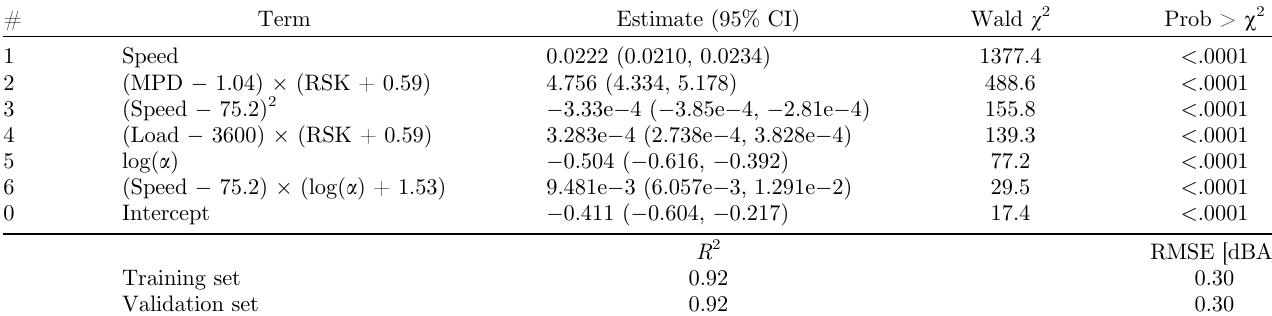
Table 3. Regression results of the summer tire. The fi rst column corresponds to the x -axis of Figure